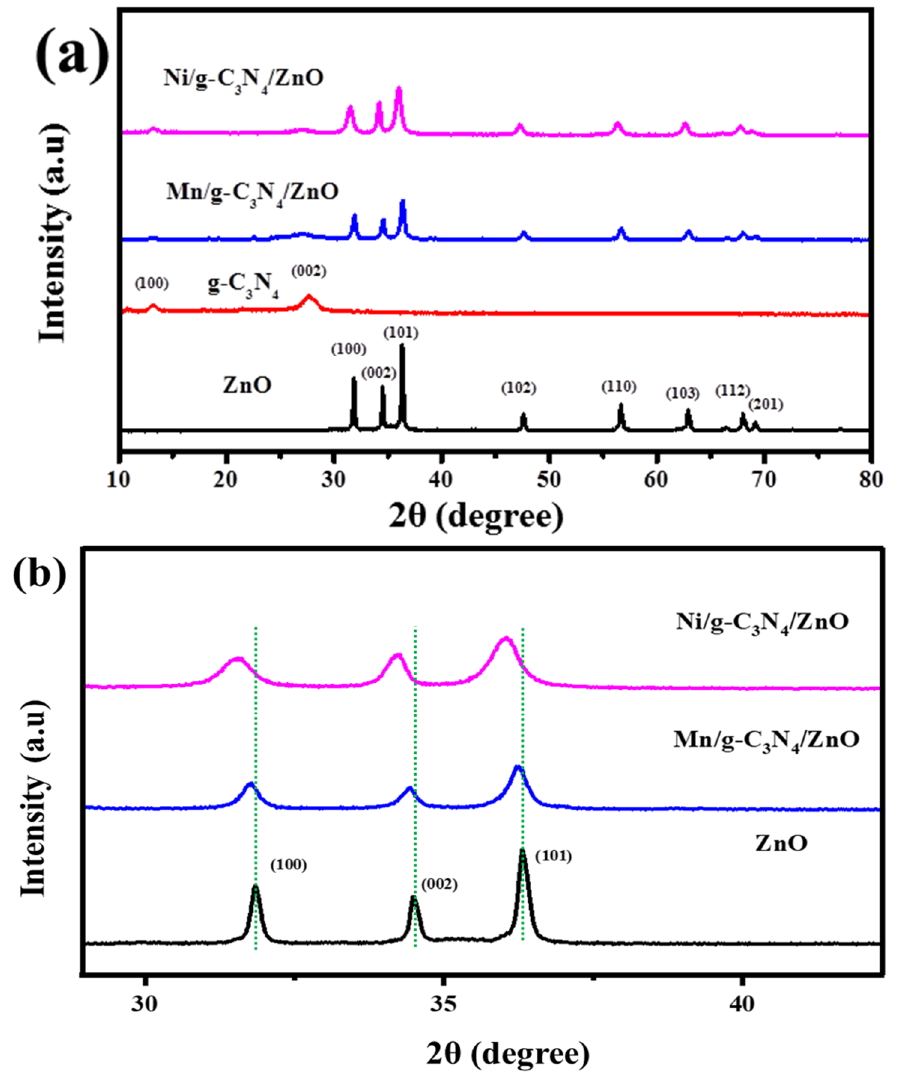
Figure 3. XRD patterns of ZnO, g-C 3 N 4 , and (Ni/Mn)/g-C 3 N 4 /ZnO NCs ( a ) Magnified XRD patterns of ZnO and (Ni/Mn)/g-C 3 N 4 /ZnO NCs ( b ).